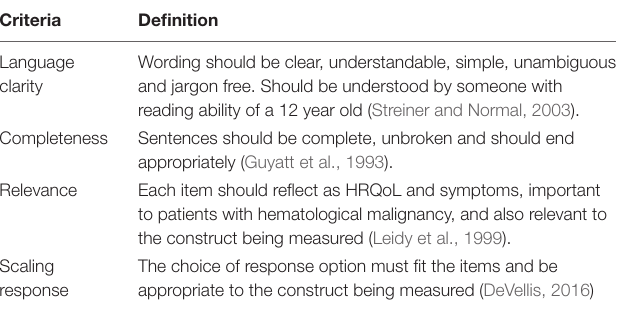
TABLE 1 | Criteria for relevance, applicability and practicality of the HRQoL